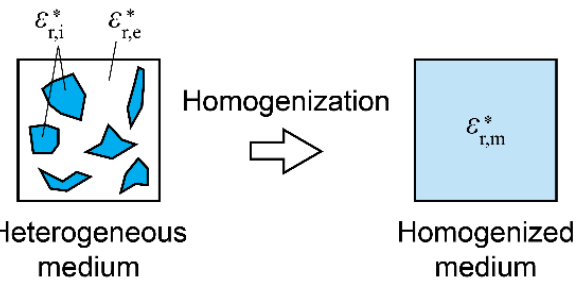
Figure 4. Conceptual illustration of homogenization of an electrically heterogeneous